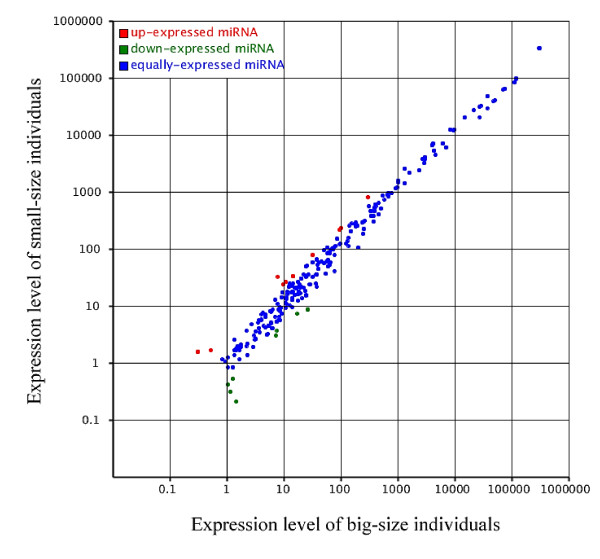
Scatter plot map for miRNA expression levels in the big-size and small-size groups of M. amblycephala. Each plot represents an individual miRNA. It reflected the proportion of miRNAs that have greater number in the big-size and small-size groups, respectively.